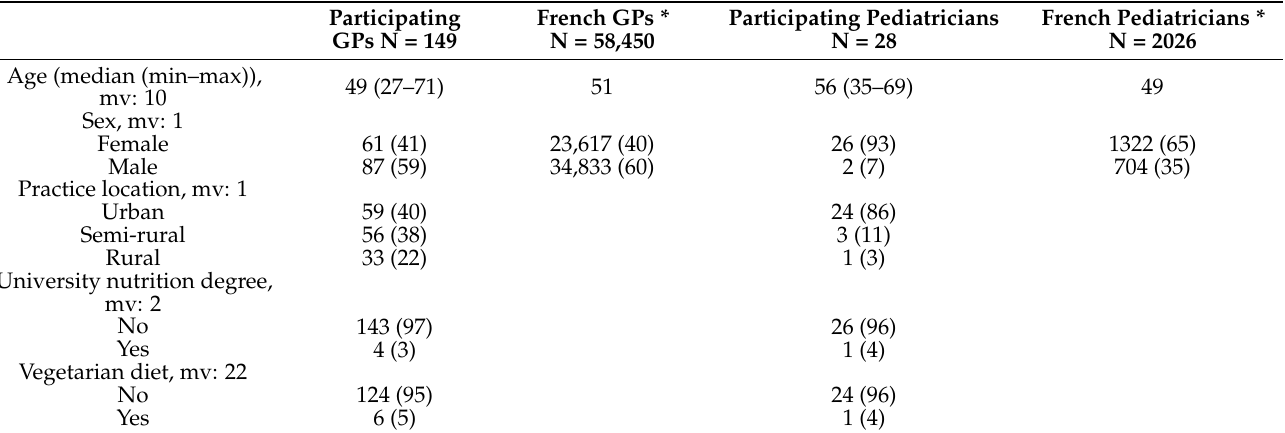
Table 1. Characteristics of participating physicians n